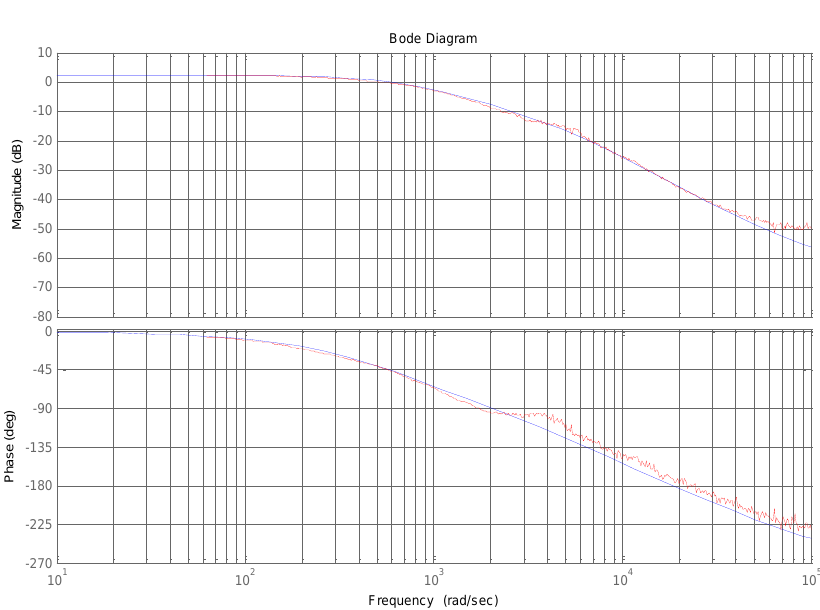
Figure 8. Control system block diagram.